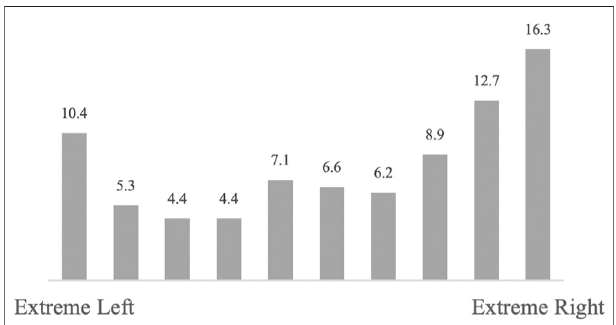
FIGURE 4 | Percentage of Respondents Strongly Agreeing that “ Immigrants Are Very Bad for the Development of the Country ” by Political Ideology. Source: European Values Study 2017, Integrated Dataset, wave 7. Own